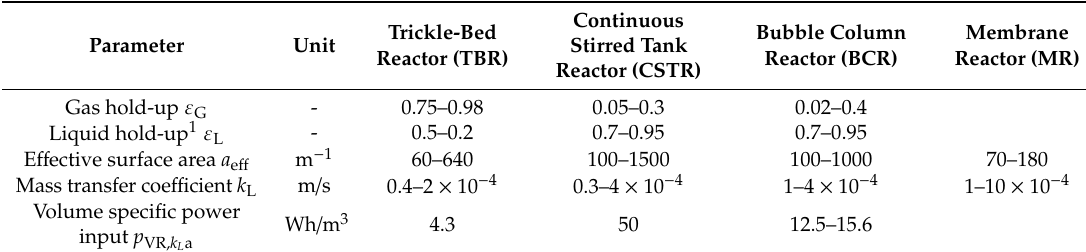
Table 5. Overview of the mass transport potential and the energy consumption related to the mass transport in the trickle-bed reactor (TBR), the stirred tank reactor (CSTR), the bubble column reactor (BCR) and the membrane reactor (MR)